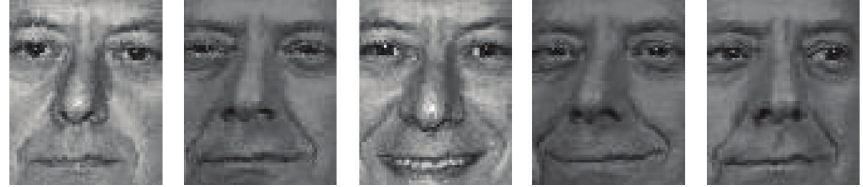
Figure 11: Five face image samples from the FERET